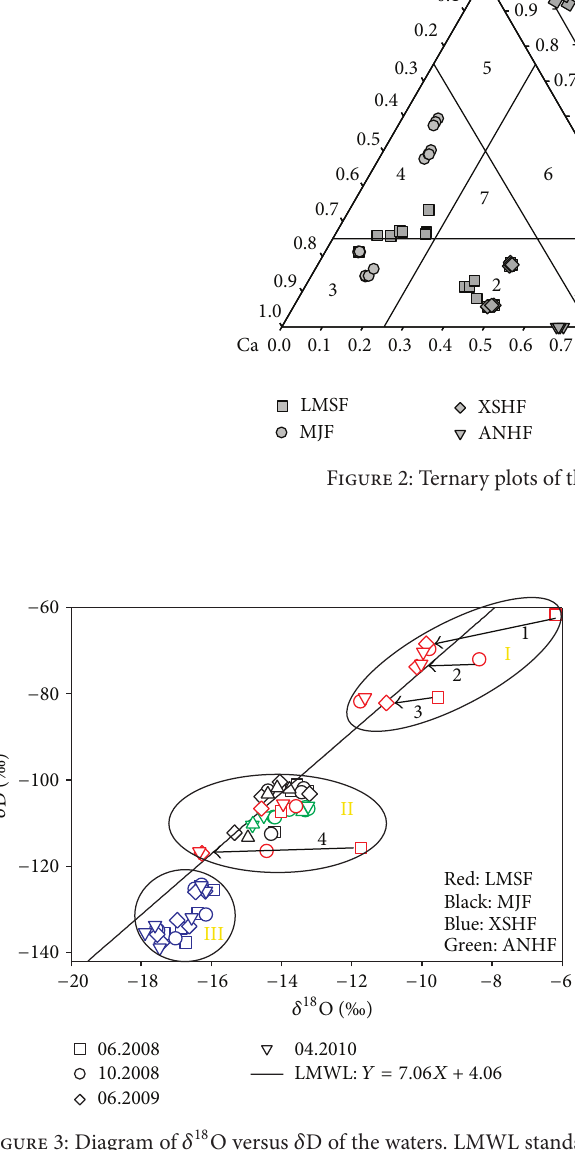
Figure 3: Diagram of 𝛿 18 O versus 𝛿 D of the waters. LMWL stands for the Local Meteoric Water Line: 𝛿 D = 7.06 𝛿 18 O −